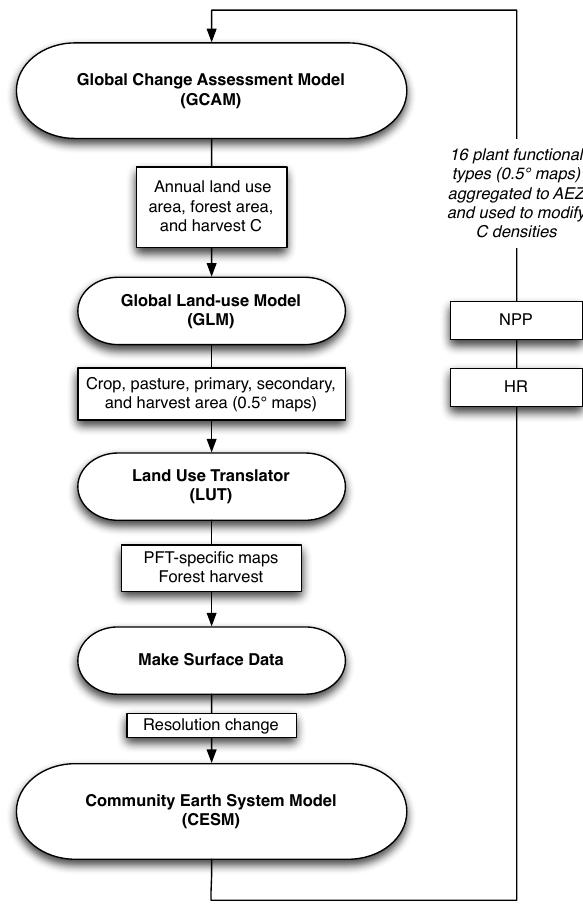
Figure 2. General iESM land use coupling algorithm. Forest area is not passed from GCAM to GLM in the CMIP5 land use coupling, but it is passed in the iESM simulations used in this study. AEZ, agro-ecological zone.